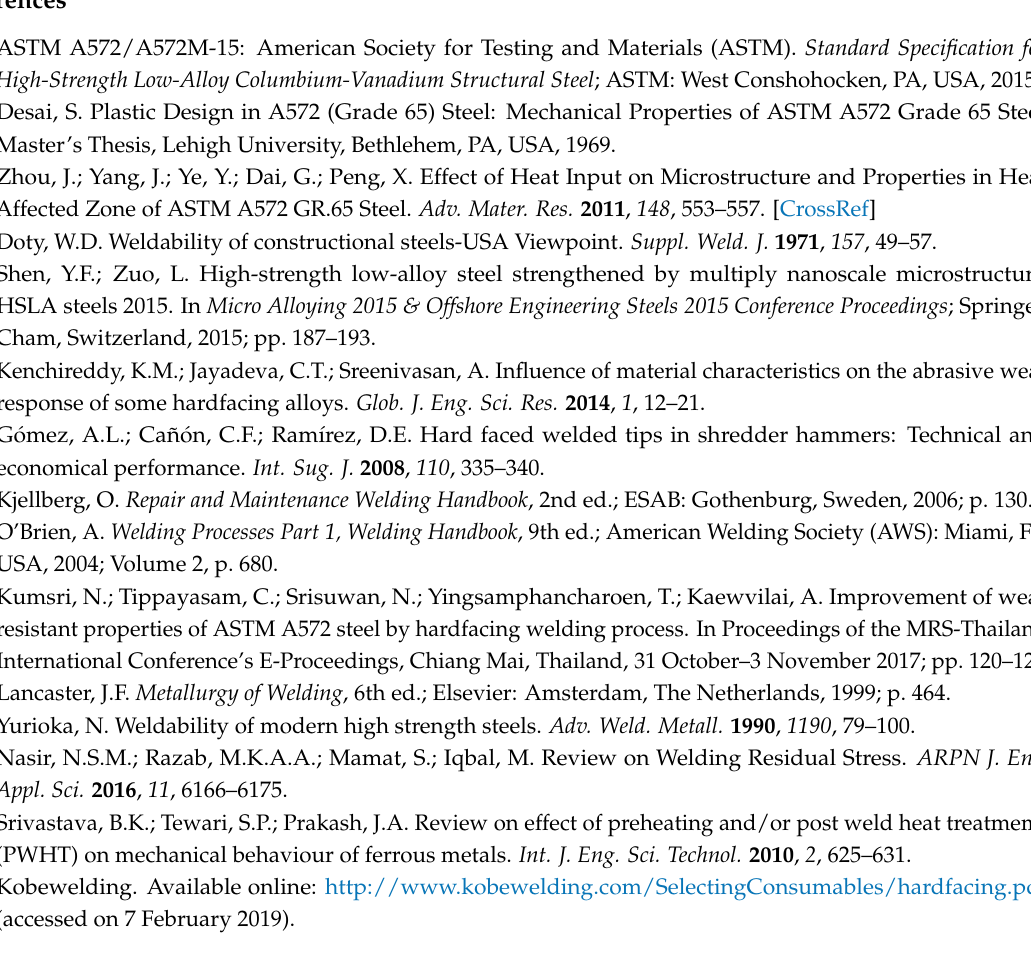
Figure S1: Weld penetration of hardfaced specimens: (a) S1, (b) S2, (c) H1 and (d) H1; Figure S2: Microscopic result at HAZ of hardfacing welded specimens: (a) S1, (b) S2, (c) H1 and (d) H2; Figure S3: Microscopic result at buffer of hardfacing welded specimens: (a) H1 and (b) H2; Figure S4: Microscopic result at hardfacing of hardfacing welded specimens: (a) S1, (b) S2, (c) H1 and (d) H2; Figure S5: The EDS spectrum of welded specimen at (a) base, (b) buffer and (c) hardfacing